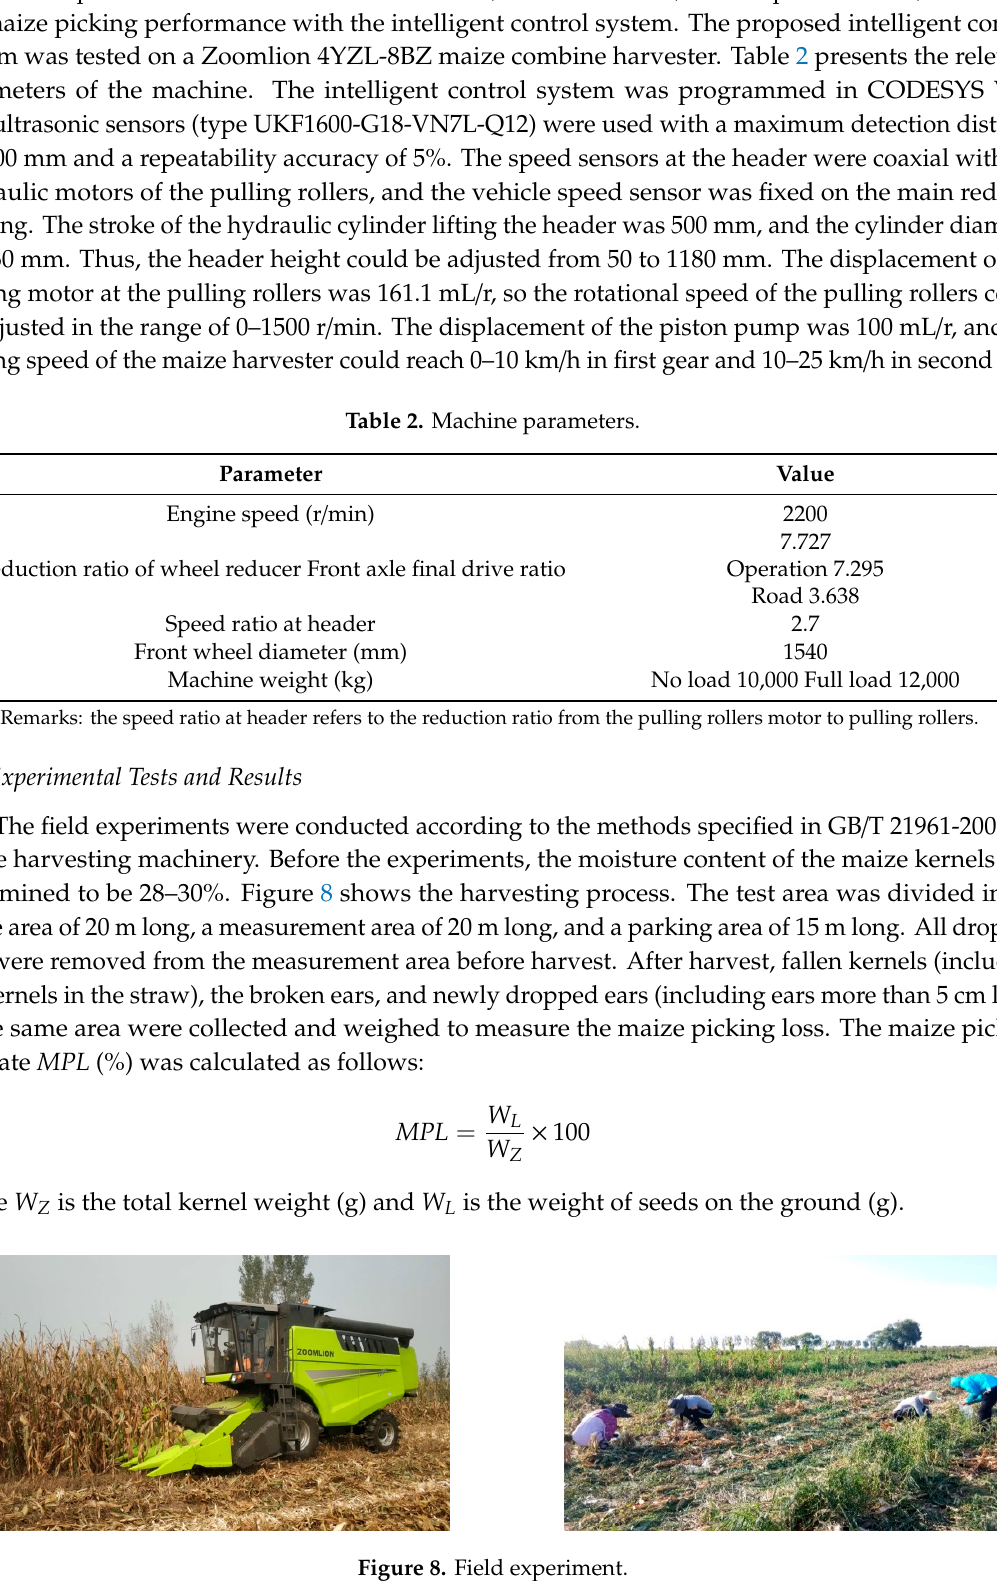
Figure 8. Field experiment.